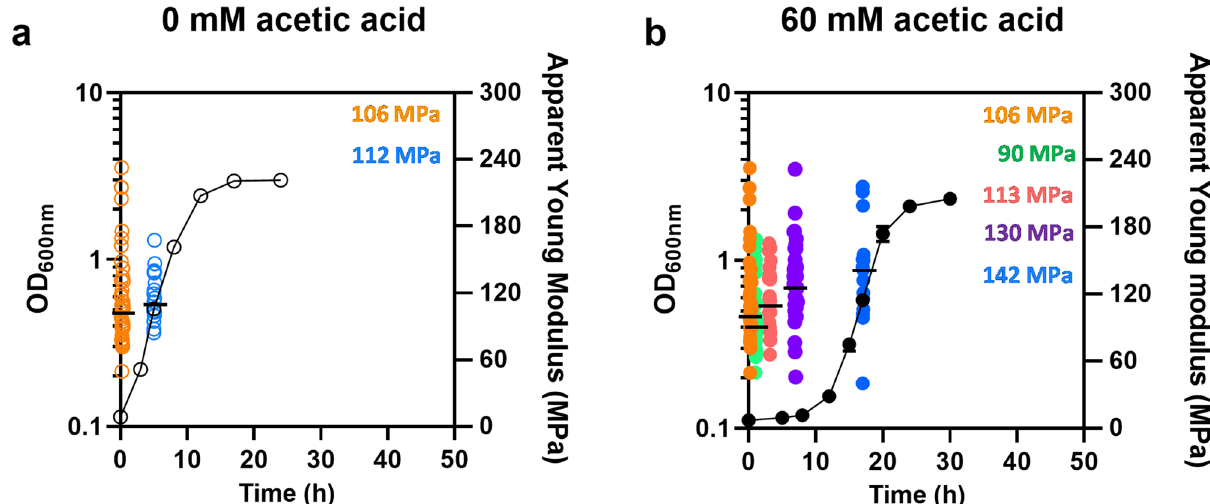
Figure 2. Apparent Young’s modulus of yeast cells during the growth curve in the absence or presence of acetic acid stress. Time-course analysis of the yeast cell surface stiffness, assessed by atomic force microscopy in BY4741 cells cultivated in the absence ( a ) or presence of acetic acid ( b ), as described for Fig. 1. The stiffness of the cell surface is represented as the apparent Young’s modulus. Each point in the graph corresponds to the median value of about 100 curves over a single cell. For each condition, at least, 15 cells were analyzed from, at least, 3 independent experiments.